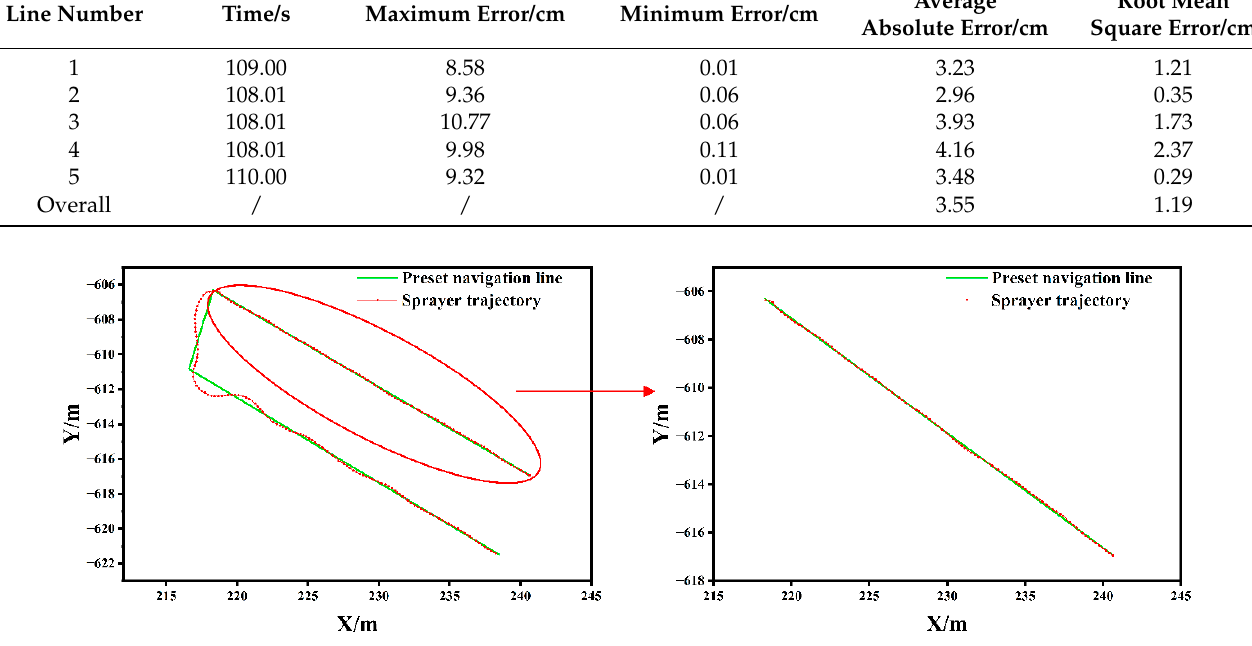
Figure 14. The navigation trajectory of the spraying robot.